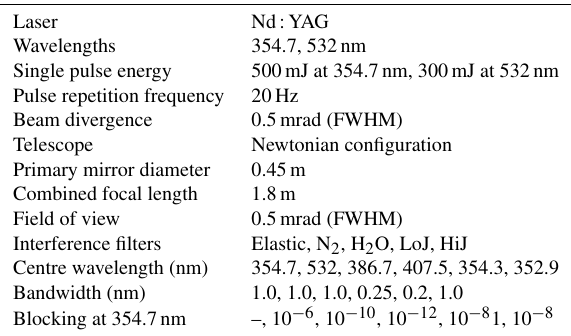
Table 1. The main characteristics of the BASIL Raman lidar sys-